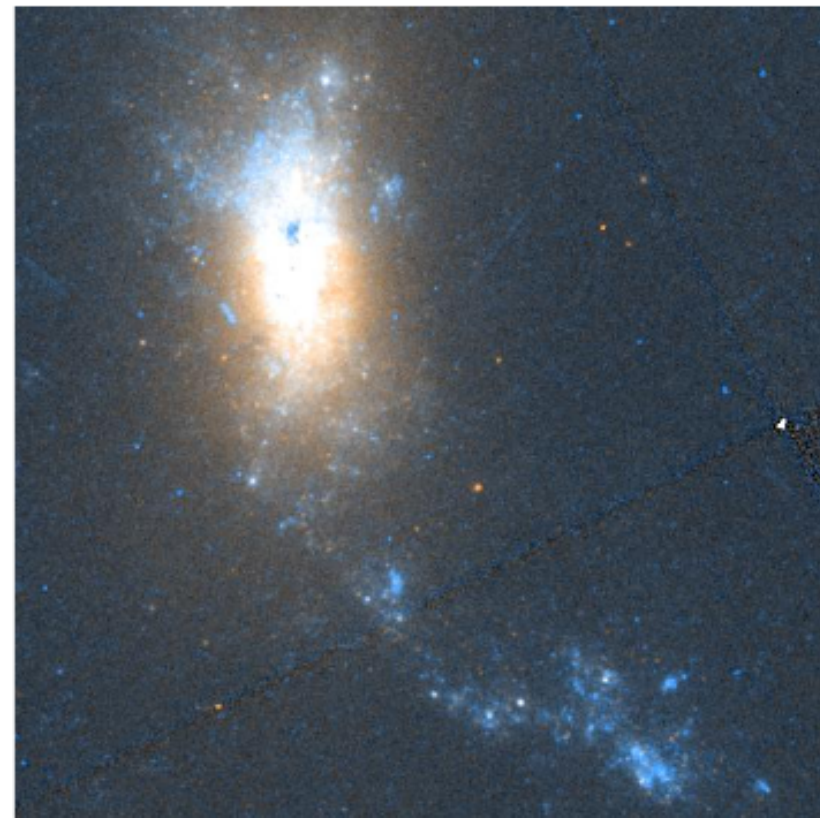
Figure 9. A composite HST image of NGC1140, taken from [74]. As in NGC 5253 (see below), CO is highly excited and not optically thick, with J = 3 → 2 line flux densities far surpassing those of the J = 1 → 0 line. Naively, one would there- fore expect high kinetic temperatures of the molecular gas giving rise to the observed CO emission. However, model fits including the dust continuum and molecular and atomic abundances relative to hydrogen [109] reveal high densities ( n (H 2 ) > 10 5 cm − 3 ) but low temperatures ( T kin ≈ 20 K), CO/C I ≈ 0.1, 12 CO/ 13 CO ≈ 8–20 and N (CO) ≈ 5 × 10 16 cm − 2 for a realistic gas-to-dust mass ratio of ≈ 380 [109]. The low kinetic temperature in combination with a rather low opacity ( τ ( J = 3 → 2) ≈ 0.2) can be explained if we assume that CO is only existing in spatially highly confined particularly well shielded pockets, where irradiation by UV photons is not as strong as elsewhere in the complex. Overall, the CO fractional abundance turns out to be ≈ 8 × 10 − 7 , two orders of magnitude below the commonly encountered value (HCN remains undetected). This is similar to the situation in the massive star forming region N159W of the LMC, where ammonia (NH 3 ), overall also highly underabundant, provides a temperature of only ≈ 16 K [186], while H 2 CO, a molecule which is less sensitive to ionizing radiation, shows kinetic temperatures of